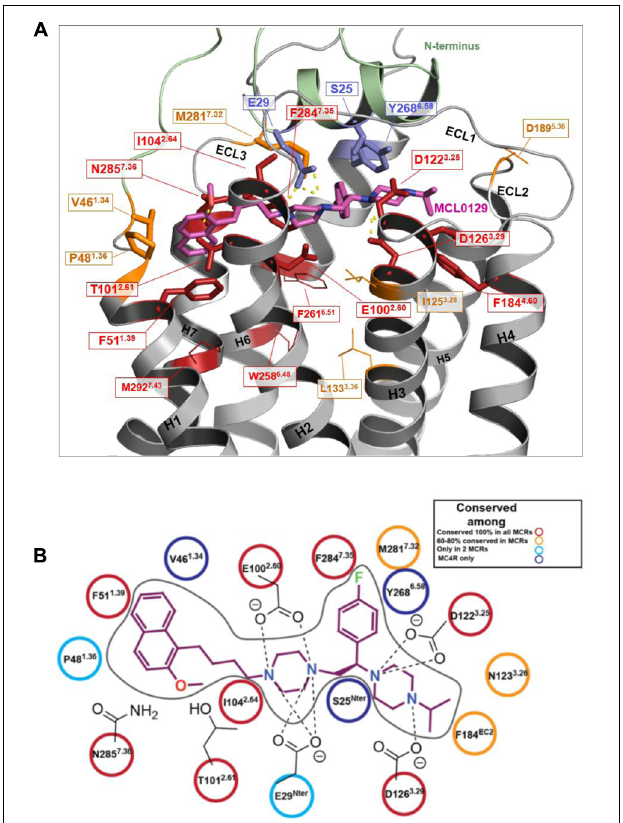
FIGURE 5 | Conservation of ligand binding site residues among the hMCR group. (A) Red: highly conserved in sequence; Orange: low sequence conservation (same residue in one further hMCR subtype or maintained biophysical properties like hydrophobic side chains); Blue: hMC4R specific amino acids (no sequence conservation); Residues shown as sticks form potential contacts between hMC4R and MCL0129; Residues shown as lines are side chains suggested to be involved in action of agonists, but not for MCL0129 binding. (B) Interaction diagram for the MCL0129-hMC4R complex color-coded based on the conservation of these interacting residues among the melanocortin